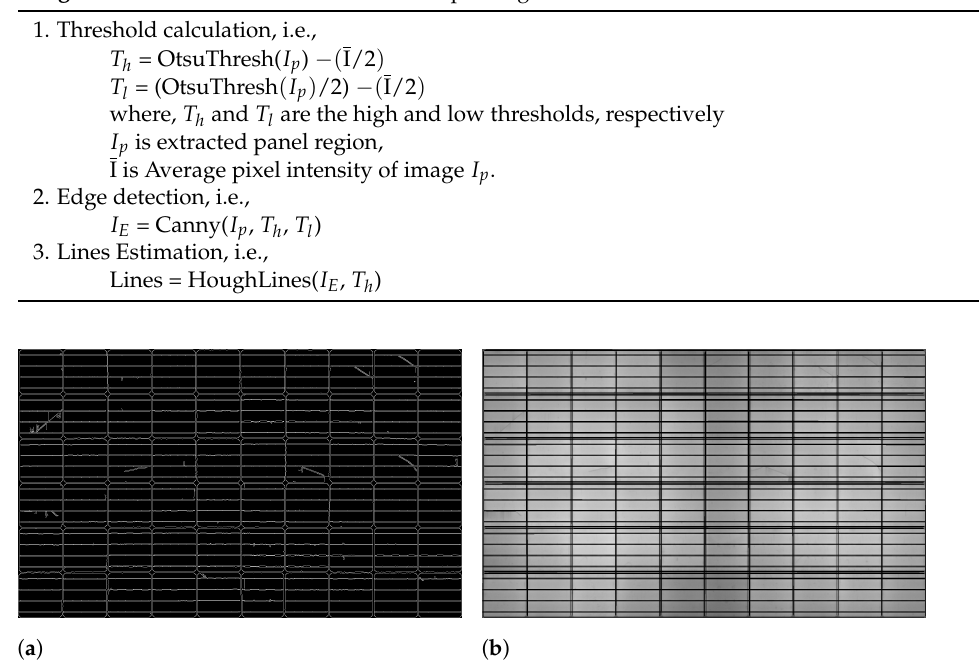
Figure 9. Horizontal and vertical lines estimation. ( a ) Edges of grids. ( b ) Horizontal and vertical lines on the panel image.